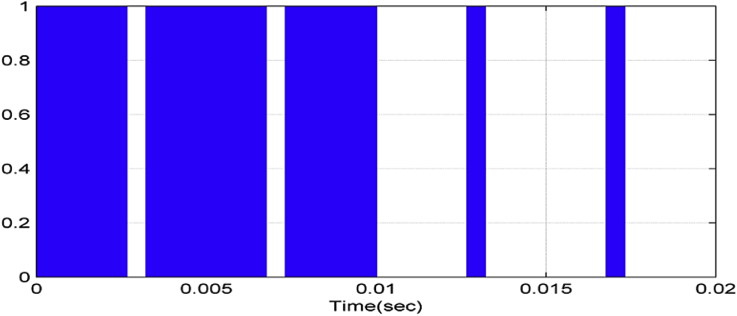
TR6 gate signal.